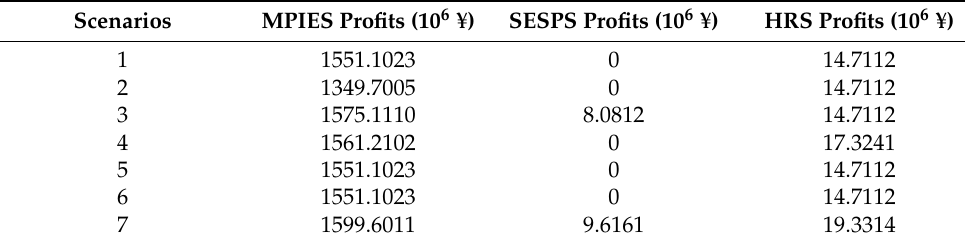
Table 4. Annual profit results.